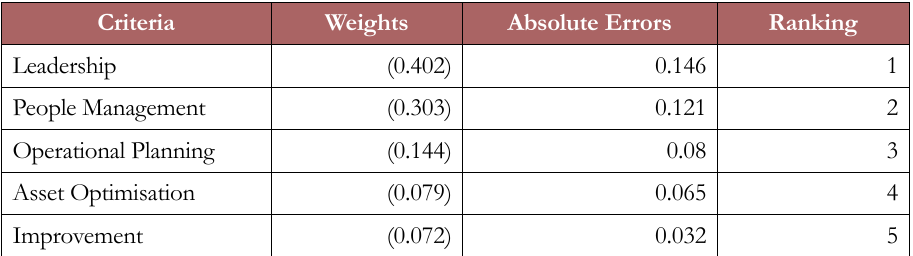
Table 6. The Ranking of the Critical Factors Based on Local